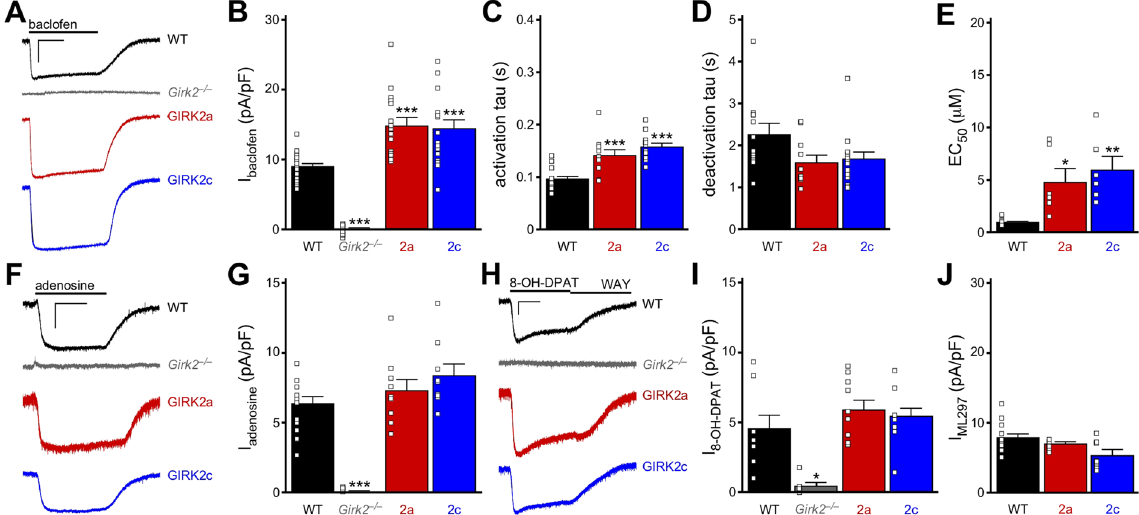
Figure 5. GPCR-GIRK currents in Girk2 − / − pyramidal neurons expressing GIRK2a or GIRK2c. ( A ) Whole- cell currents (V hold = − 70 mV) evoked by baclofen (100 μ M) in a wild-type pyramidal neuron expressing EGFP (WT, black), as well as Girk2 − / − pyramidal neurons expressing EGFP ( Girk2 − / − , gray), GIRK2a (red), or GIRK2c (blue). Scale: 1 nA/5 s. ( B ) Summary of baclofen-induced, steady-state current densities (pA/pF) in wild- type control and Girk2 − / − pyramidal neurons expressing EGFP, GIRK2a, or GIRK2c (F 3,53 = 44.8, P < 0.001; n = 11–16/group). Symbols: *** P < 0.001 vs. WT. ( C,D ) Summary of activation (C; F 2,35 = 19.2, P < 0.001) and deactivation ( D ) F 2,33 = 2.76, P = 0.08) kinetics for baclofen-induced currents in infected wild-type and Girk2 − / − pyramidal neurons. Symbols: *** P < 0.001 vs. WT (n = 11–15 per group). ( E ) EC 50 values for baclofen-induced currents in infected wild-type and Girk2 − / − pyramidal neurons expressing GIRK2a or GIRK2c (F 2,17 = 8.84, P < 0.01; n = 6–8/group). Symbols: * , ** P < 0.05 and 0.01, respectively, vs. WT. ( F ) Whole-cell currents evoked by adenosine (10 μ M) in a wild-type pyramidal neuron expressing EGFP, as well as Girk2 − / − pyramidal neurons expressing EGFP, GIRK2a, or GIRK2c (V hold = − 70 mV). Scale: 500 pA/5 s. ( G ) Summary of adenosine-induced, steady-state current densities (I adenosine , pA/pF) in wild-type control and Girk2 − / − pyramidal neurons expressing EGFP, GIRK2a, or GIRK2c (F 3,36 = 32.1, P < 0.001; n = 9–13/group). Symbols: *** P < 0.001 vs. WT. ( H ) Whole- cell currents evoked by 8-OH-DPAT (10 μ M) in a wild-type pyramidal neuron expressing EGFP, as well as Girk2 − / − pyramidal neurons expressing EGFP, GIRK2a, or GIRK2c (V hold = − 70 mV). As currents evoked by 8-OH-DPAT persisted following bath washout, the 5HT 1A R-selective antagonist WAY100635 (WAY, 2 μ M) was used to demonstrate reversibility of the 8-OH-DAT response. Scale: 500 pA/5 s. ( I ) Summary of 8-OH-DPAT- induced, steady-state current densities (I 8-OH-DPAT , pA/pF) in wild-type control and Girk2 − / − pyramidal neurons expressing EGFP, GIRK2a, or GIRK2c (F 3,30 = 7.92, P < 0.001; n = 5–11/group). Symbols: * P < 0.05 vs. WT. ( J ) Summary of current densities (pA/pF) evoked by 10 μ M ML297 (I ML297 ) in wild-type control and Girk2 − / − pyramidal neurons expressing EGFP, GIRK2a, or GIRK2c (F 2,12 = 2.0, P = 0.16; n =